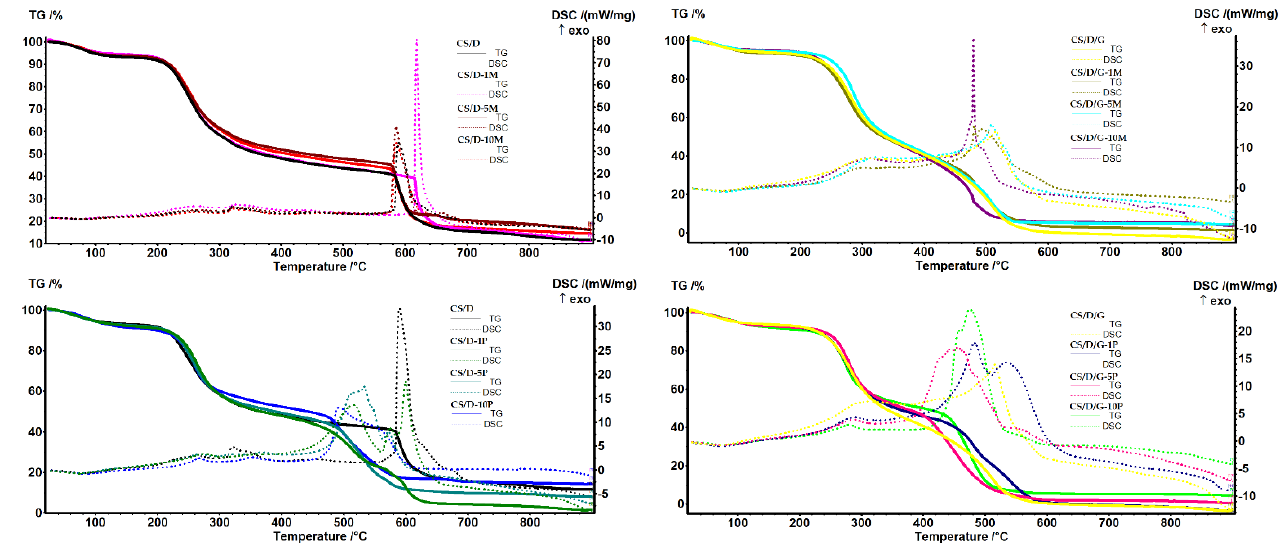
Figure 7. TG-DSC curves for the CS/D and CS/D/G